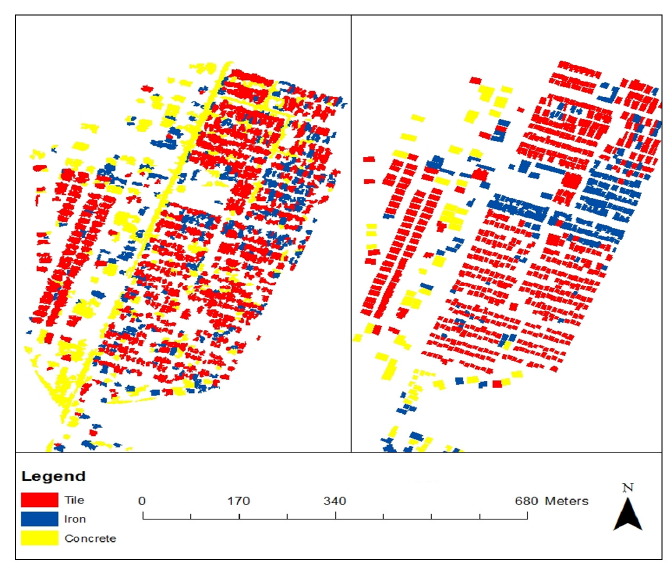
Figure 6. Comparison between manually digitized and automatic classification for a portion of the classified area (only roofing materials shown). Table 8. Area of different roof materials (in m 2 ) resulting from the manual digitization for the selected control areas. Tile Iron Concrete